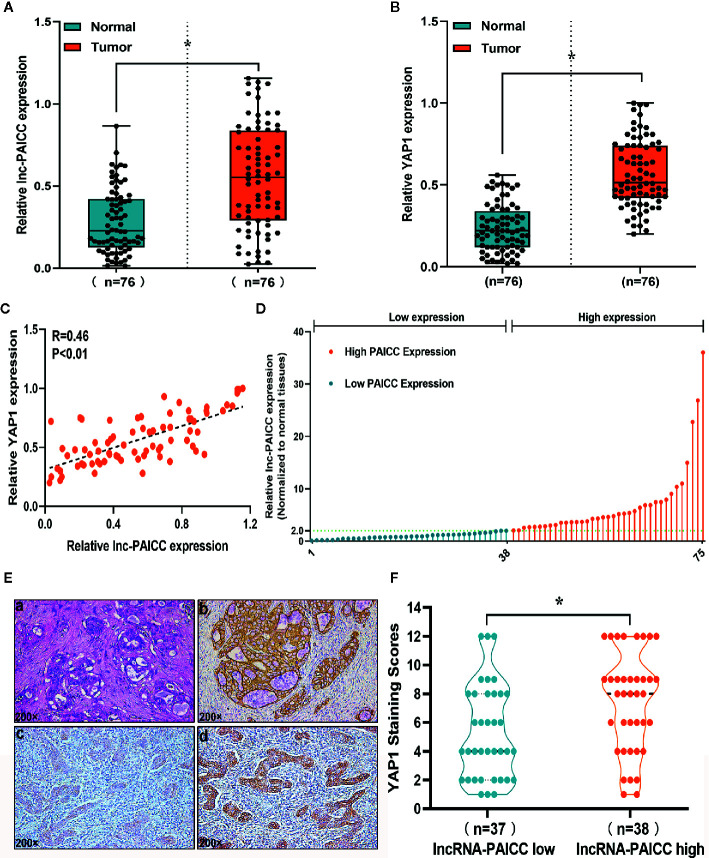
The novel lncRNA is closely related to YAP1 expression. (A) The relative expression levels of lncRNA-PAICC in 76 pairs of ICC tumors and corresponding adjacent normal tissues were detected by RT-PCR. Data are mean ± SD (n = 76), *P<0.05. (B) The relative expression levels of YAP1 in 76 pairs of ICC tumors and corresponding adjacent normal tissues were detected by RT-PCR. Data are mean ± SD (n = 76), *P<0.05. (C) The correlation between lncRNA-PAICC transcript level and YAP1 mRNA transcript level was measured in 76 ICC tissues. The 2−△△Ct values were subjected to Spearman’s correlation analysis. (D) The patients were classified into two groups according to relative lncRNA-PAICC expression level. (E) Staining of paraffin sections of human ICC tissue. (a) Hematoxylin and eosin-stained images of ICC tissues; (b) CK19 expression in ICC tissue; (c) Weak expression of YAP1 in ICC tissue; (d) High expression of YAP1 in ICC tissue. (F) In the low or high expression groups of lncRNA-PAICC, the average staining score of YAP1 was evaluated by the scatter plot. Data are mean ± SD. *P < 0.05.